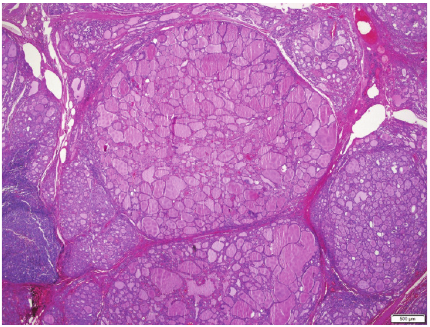
Figure 5: Multinodular goiter (H&E, 20x).